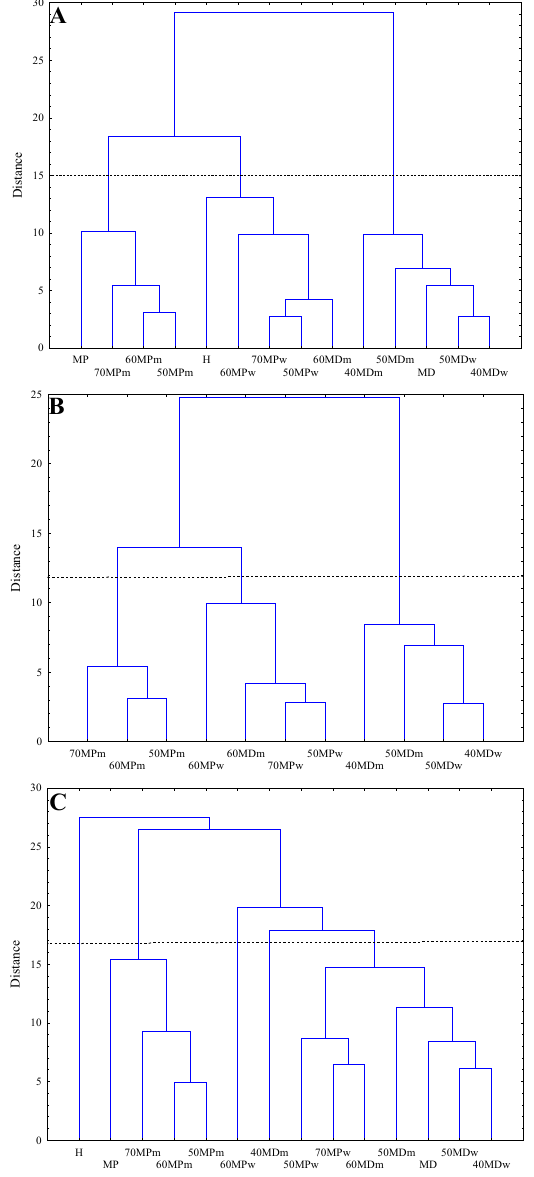
Figure 2. Hierarchical clustering analysis (HCA) tree diagram. ( A )—analysis performed on all 14 samples in the range between 1800–750 cm − 1 , ( B )—analysis performed on 11 samples from II–V group in the range between 1800–750 cm − 1 , and ( C )—analysis performed on all 14 samples in the range between 3600–750 cm − 1 .